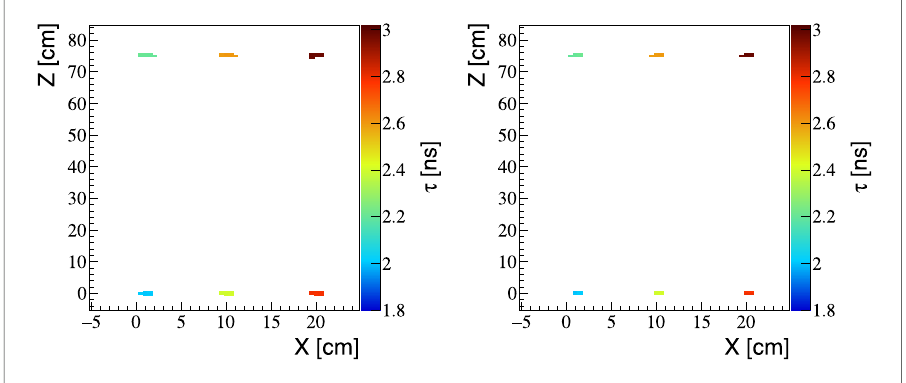
Fig. 6 Distributions of generated positronium lifetimes „ and reconstructed ones, assuming the CRT value of 10 ps ( b ), 50 ps ( c ), 140 ps ( d ) and 500 ps ( e ). The voxel size is equal to 5 × 5 × 5 mm